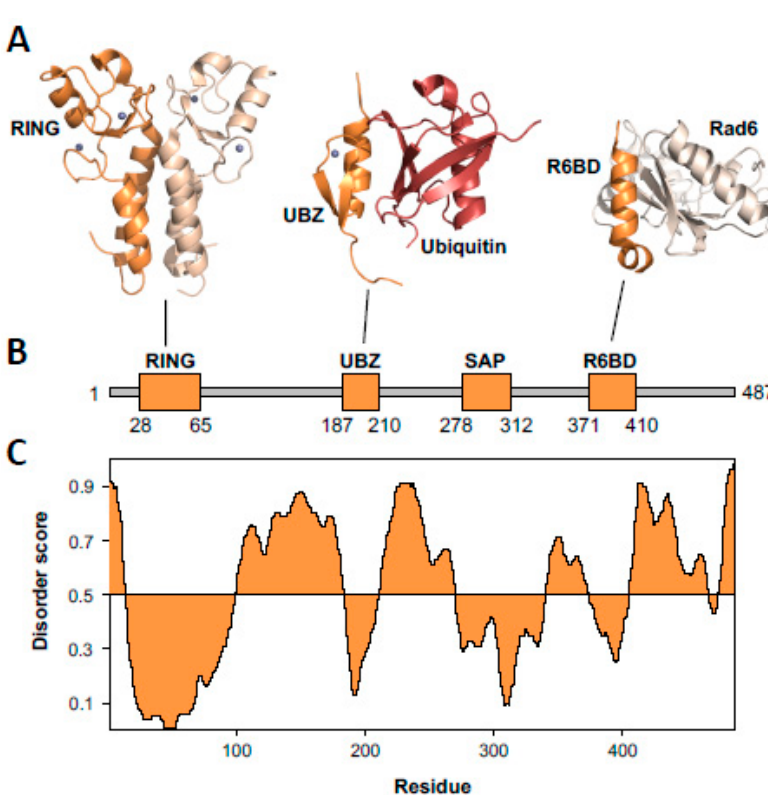
Figure 3. Structure of Rad18. ( A ) Ribbon diagrams of the Rad18 Really Interesting New Gene (RING) domain dimer (dark orange and light orange) (2Y43.pdb) [44], the Rad18 Ubiquitin-Binding, Zinc-Binding (UBZ) domain (dark orange) bound to ubiquitin (red) (2MRE.pdb) [45], and the Rad18 R6BD domain (dark orange) bound to Rad6 (light orange) (2YBF.pdb) [42]. The zinc ions are shown as spheres. ( B ) A linear diagram of Rad18 shows the structured domains as thick, orange rectangles and the intrinsically disordered regions as thin, grey rectangles. ( C ) A disorder plot of Rad18 was generated using the Protein Disorder Prediction Server [46].